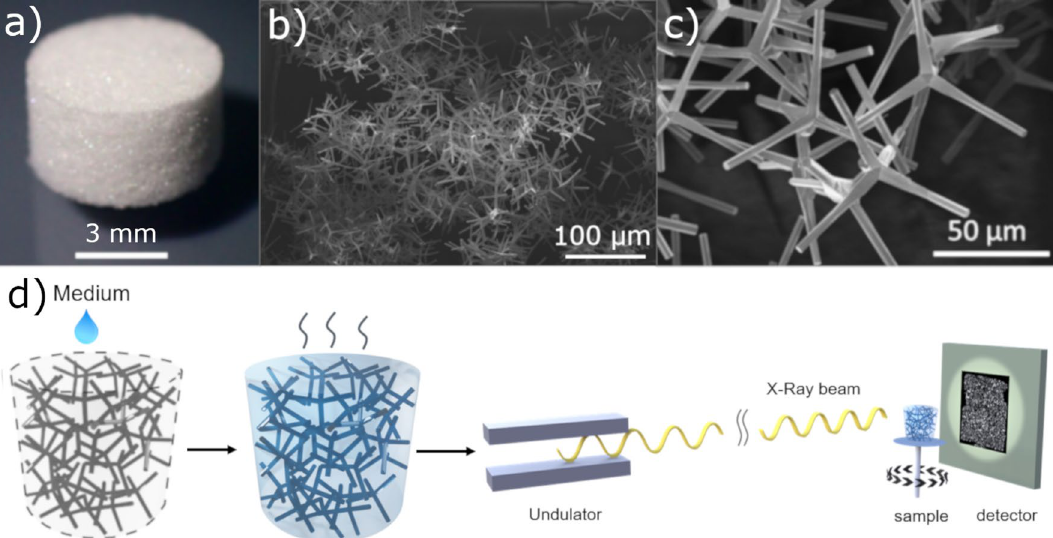
Figure 1. ( a ) Exemplary image of a fabricated t-ZnO template with a porosity ~ 94%, ( b ) low magnification SEM micrograph of t-ZnO powder, ( c ) high magnification SEM micrograph of t-ZnO powder produced by the FTS approach, and ( d ) schematic illustration of the experimental procedure. In the first step, the porous t-ZnO network is infiltrated with the medium. In the next step, the medium is evaporating in situ during the imaging of the process using